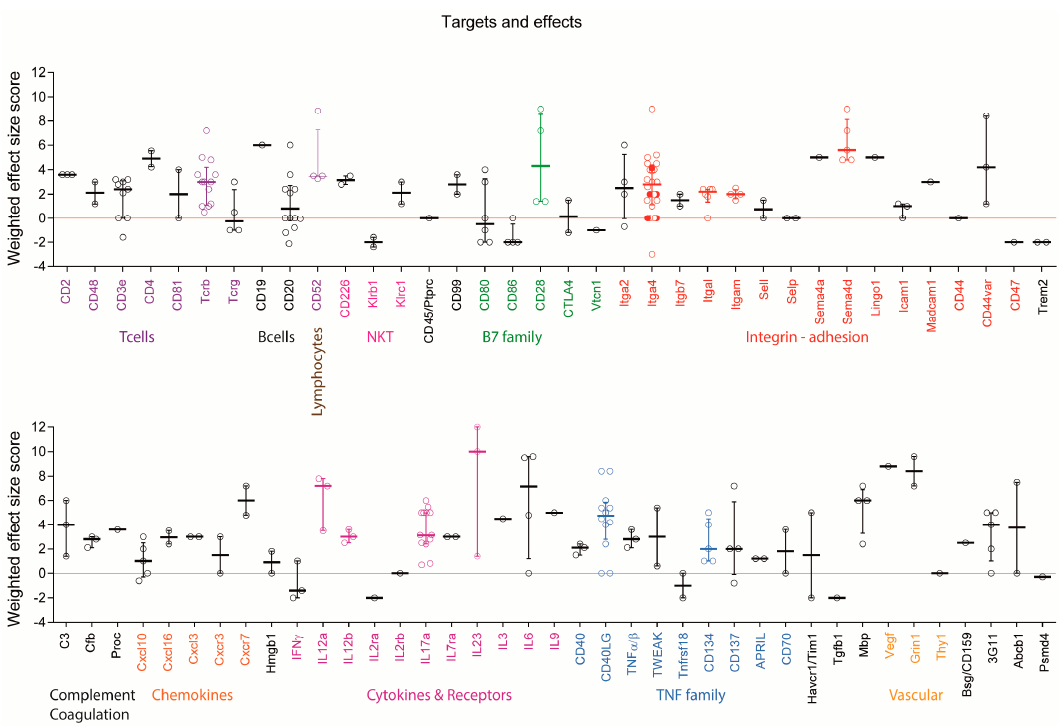
Figure 7. Scatter plots showing the weighted effect size scores per experiment including targets with at least 2 experiments. Itga4 (VLA-4) was the most frequently targeted molecule. Results of our own studies targeting Itga4 appear as filled red dots. Worsening with anti-Itga4 occurred in a late adoptive transfer experiment, where it increased the relapse rate. Promising targets with at least 4 positive experiments (effect size > 0) and no aggravations are highlighted by color of the respective group. For some targets, the classification of “promising” is based on results of only one study (3G11 epitope, Mbp, CD134/Tnfrsf4, Itgal/CD11a). One failure (effect size 0) for CD40LG was caused by low dose.